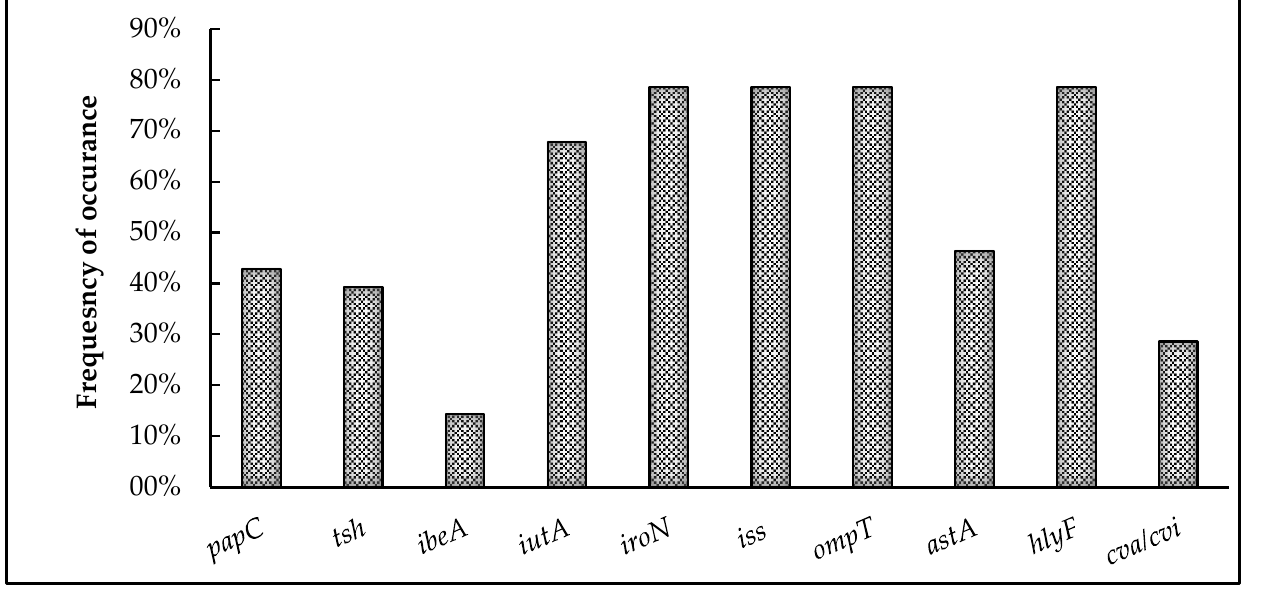
Figure 3. Prevalence of virulence-associated genes among broiler breeder APEC isolates. papC and tsh code for adhesins; ibeA for invasin; iutA and iroN indicate iron acquisition systems; iss and ompT for protectins; astA and hylF indicate toxins; and cva/cvi is part of the colicin V plasmid.